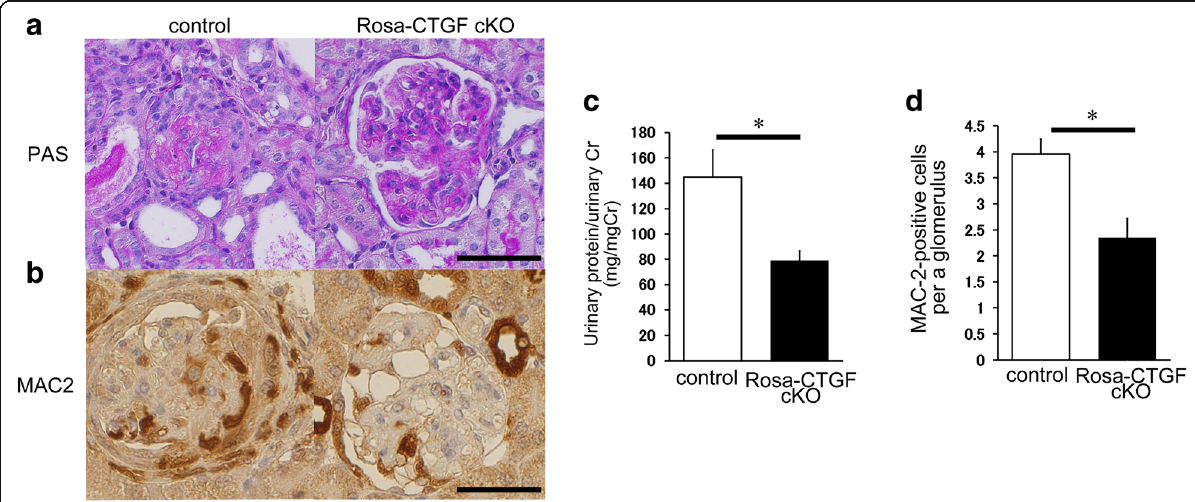
Fig. 2 Macrophage recruitment in Rosa-CTGF cKO mice with anti-GBM nephritis at the earlier stage. a Representative photomicrographs of the kidneys at 1 week after induction of anti-GBM nephritis (PAS staining). Left upper panel, control mice with anti-GBM nephritis; right upper panel show, Rosa-CTGF cKO mice with anti-GBM nephritis. Bar represents 50 μ m. b Immunohistochemical studies for MAC-2 at 1 week after induction of anti-GBM nephritis. Bar represents 50 μ m. c Changes in proteinuria at 1 week after induction of anti-GBM nephritis. d The number of MAC-2- positive cells at 1 week after induction of anti-GBM nephritis. Values are expressed as means± s.e. * P < 0.05, ** P < 0.01 vs. control